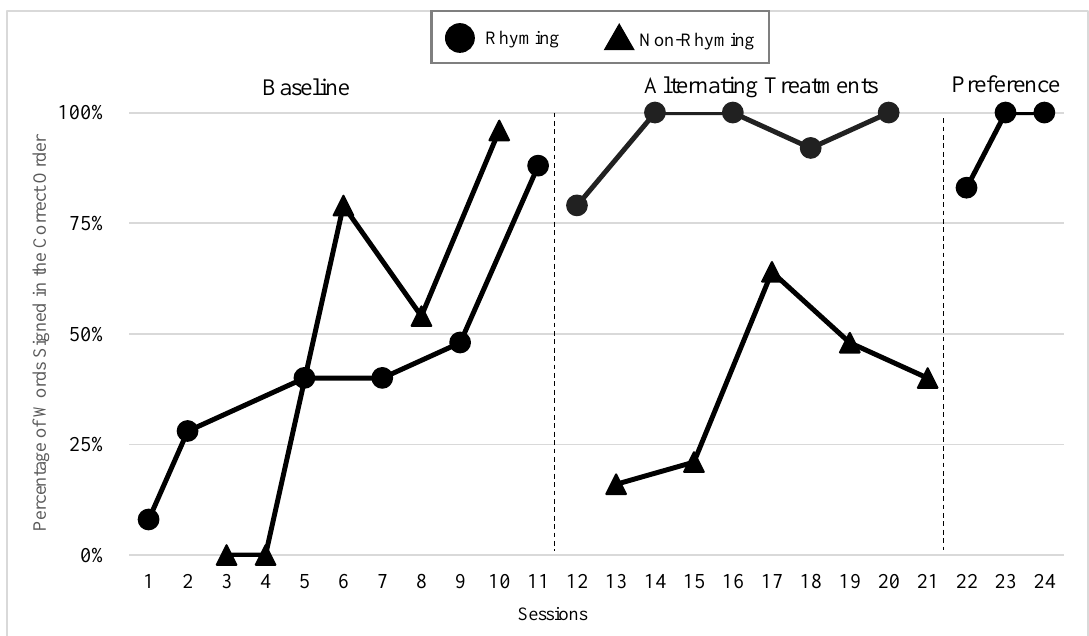
Figure 13. Jaslene’s Percentage of Words Signed Correctly in Recitation.